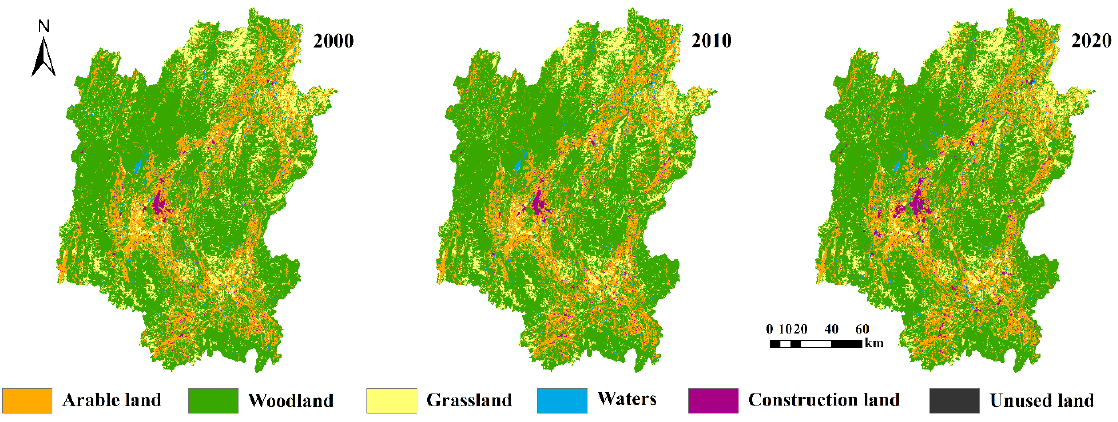
Figure 2. Land use types of Guilin from 2000 to 2020.